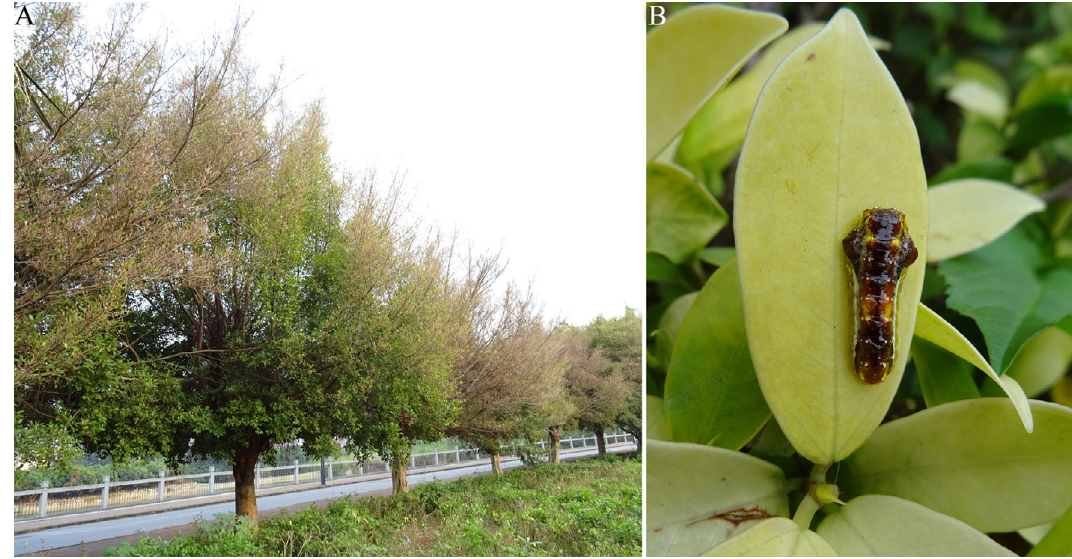
Figure 1. A. Ficus microcarpa damaged by Phauda flammans larvae; B. Phauda flammans